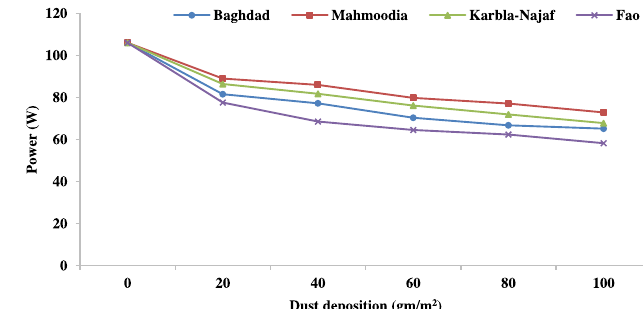
Fig. 6. Power reduction due to dust accumulation on PV surface for the tested dust types.